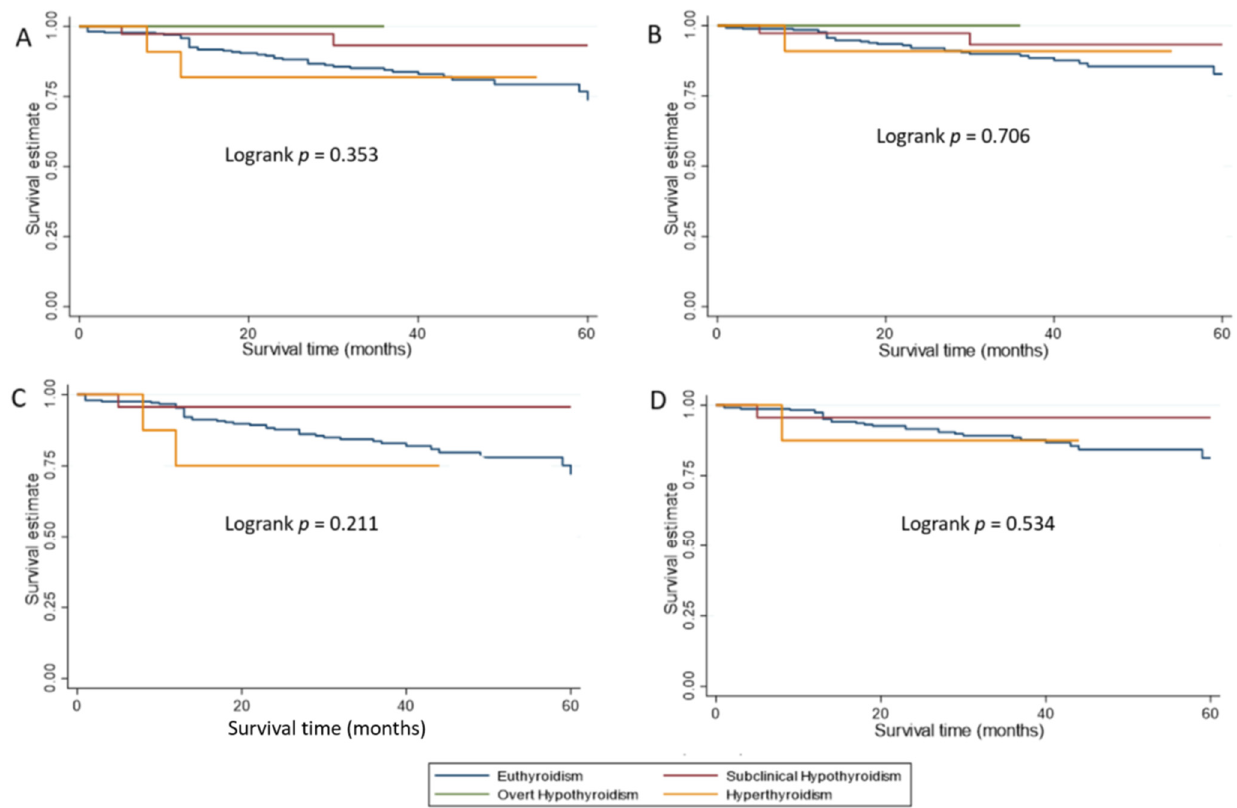
Figure 1. Kaplan–Meier survival curves showing survival estimates by biochemical thyroid status at endometrial cancer diagnosis. ( A ) Overall survival estimates for the whole study cohort. ( B ) Cancer-specific survival estimates for the whole cohort. ( C ) Overall survival estimates for the cohort with no history of hypothyroidism. ( D ) Cancer-specific survival estimates for the cohort with no history of hypothyroidism.